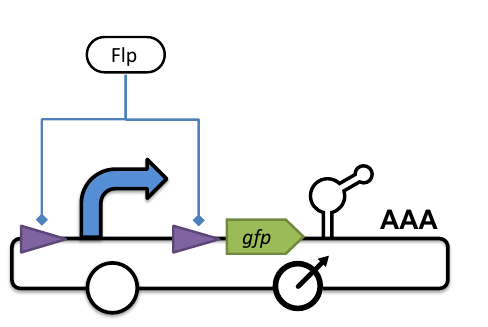
Figure 37: Promoter regulating the expression of GFP, which is also regulated by an aptamer between it and the poly-A tail of the transcript. The promoter can be cut out by a pair of recombinase target sites, which are acted on by the Flp protein. The whole construct is stored in a circular plasmid with an origin of replication and also an origin of transfer.